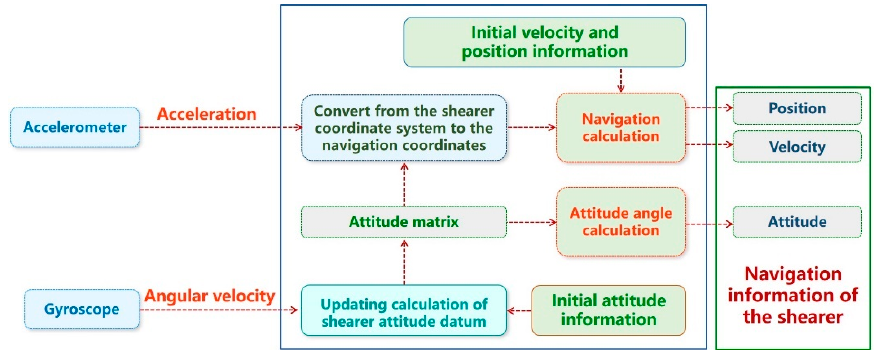
Figure 3. Principle of the shearer positioning system based on SINS.